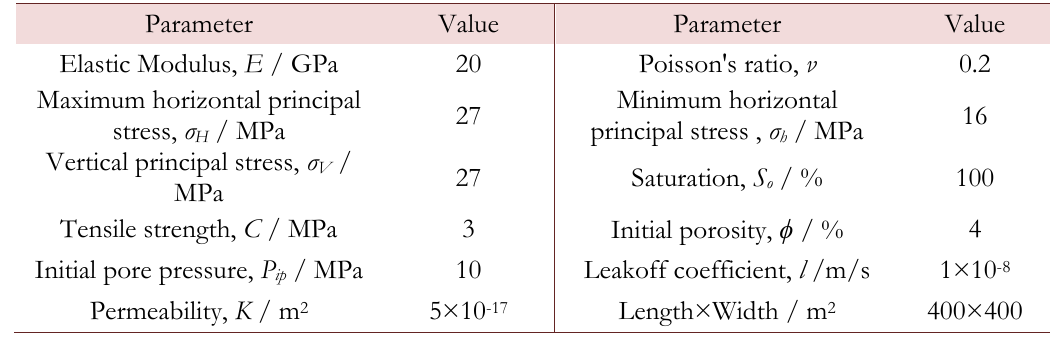
Table 1: Model parameters of shale gas